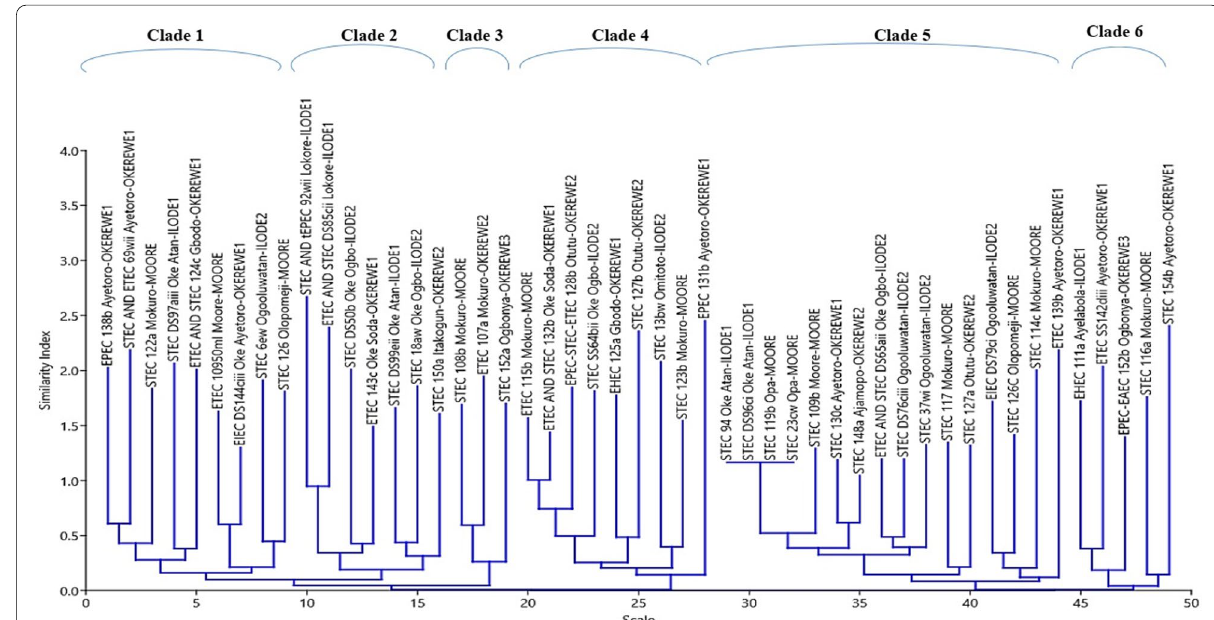
Fig. 4 Neighbour-joining dendrogram clusters of (GTG)5-fingerprints of strains with their